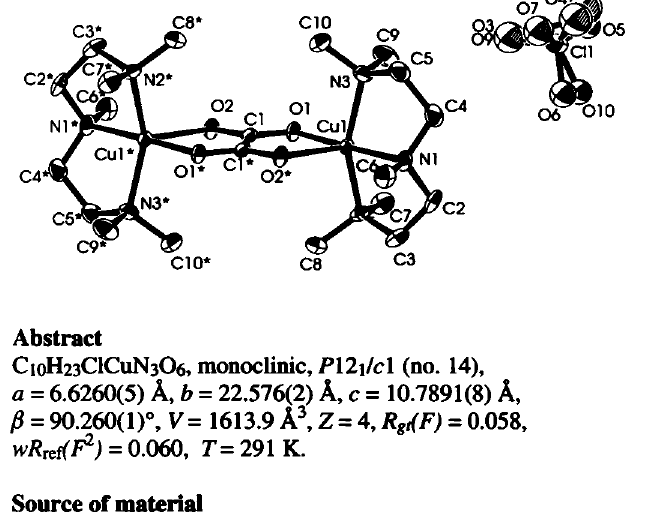
Table 1. Data collection and handling.